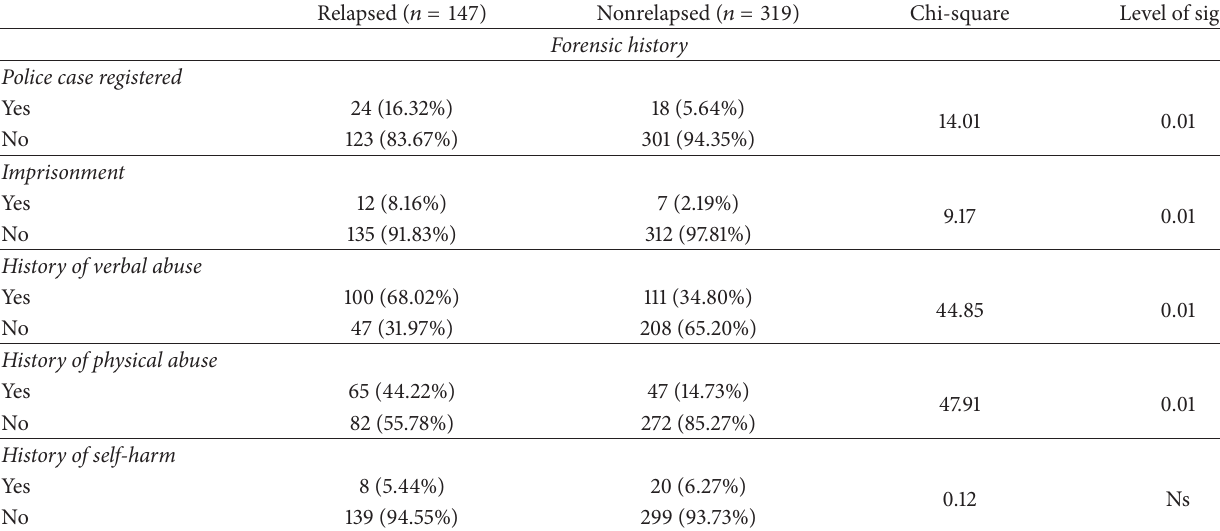
Table 3: Forensic